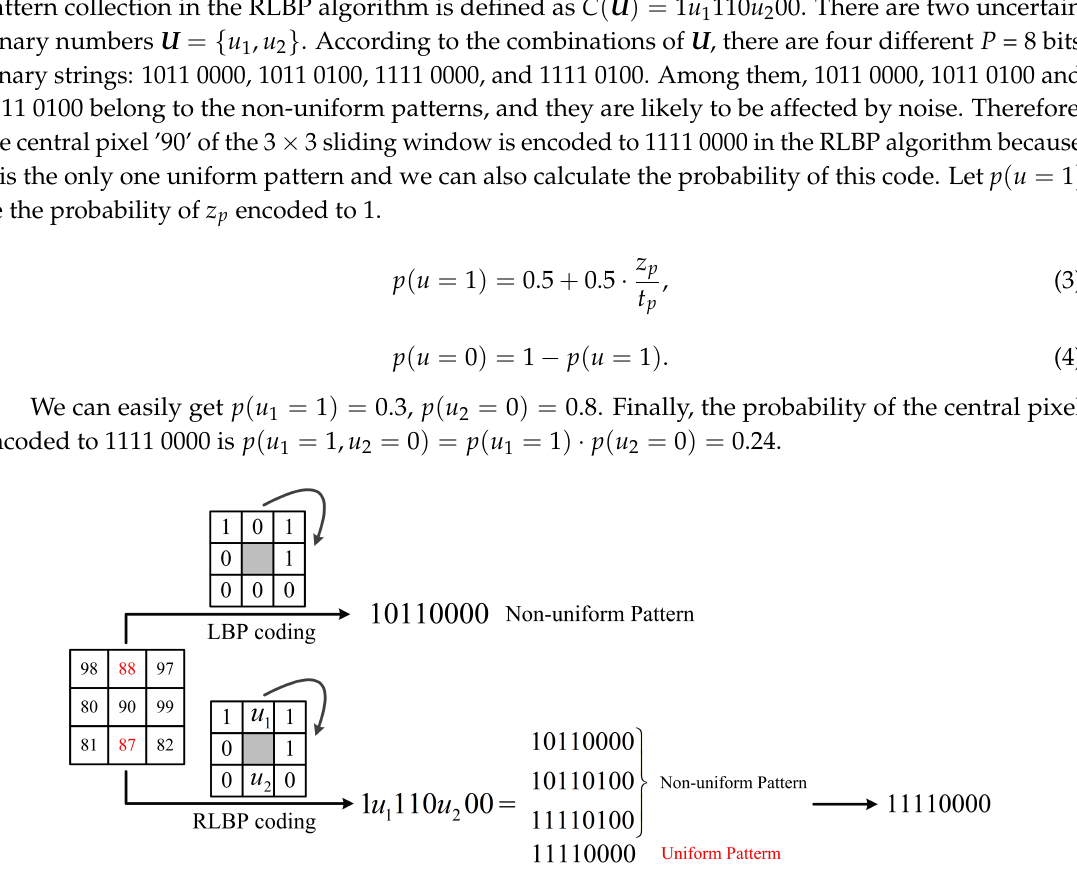
Figure 5. The comparison of LBP and RLBP patterns in a 3 × 3 sliding window with only one pattern in uncertain RLBP pattern collection belongs to the uniform